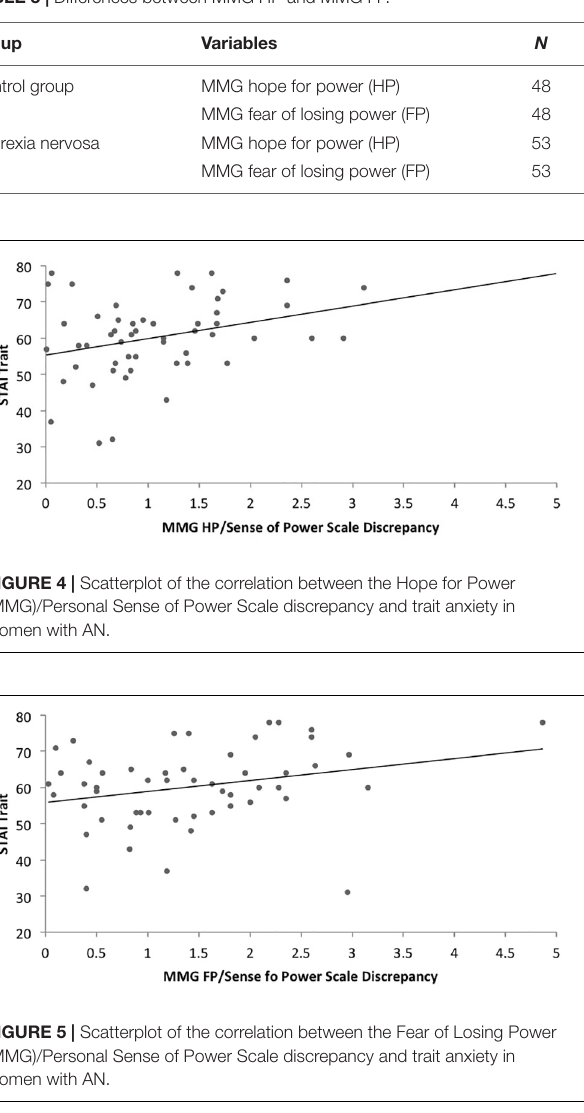
TABLE 3 | Differences between MMG HP and MMG FP.